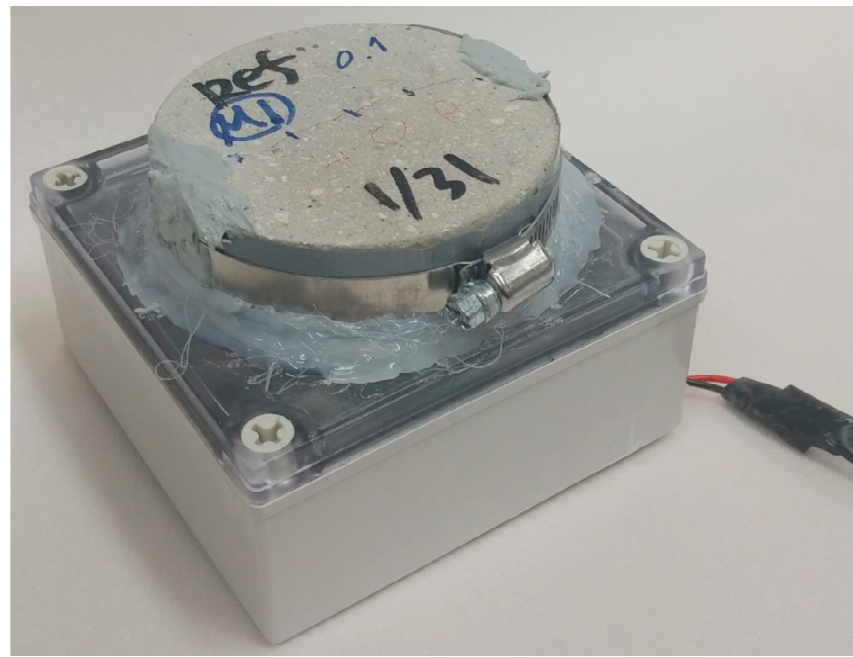
Figure 3. Mortar specimens attached on the airtight container.